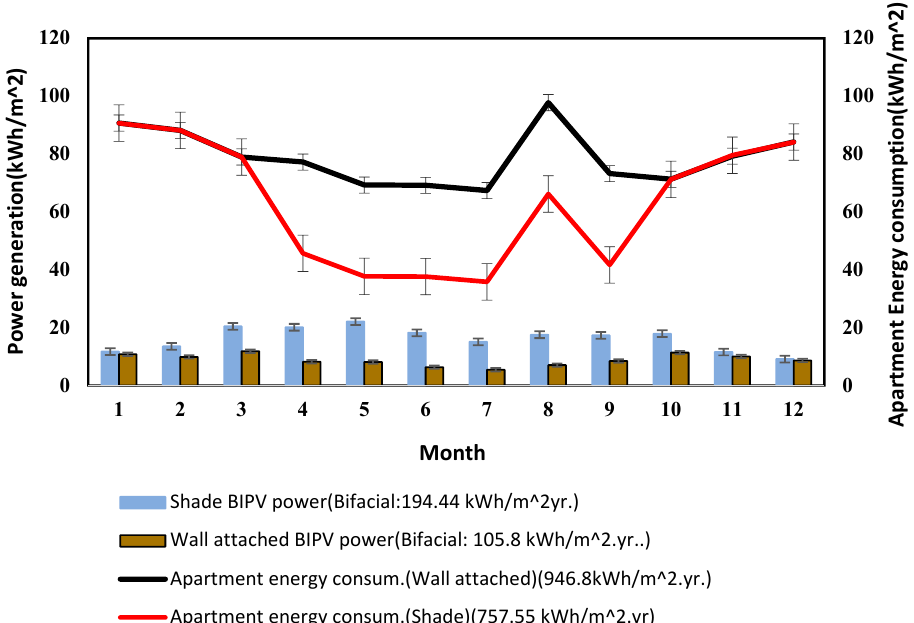
Figure 12. The power generation and the apartment energy consumption between the two different types of PV systems.